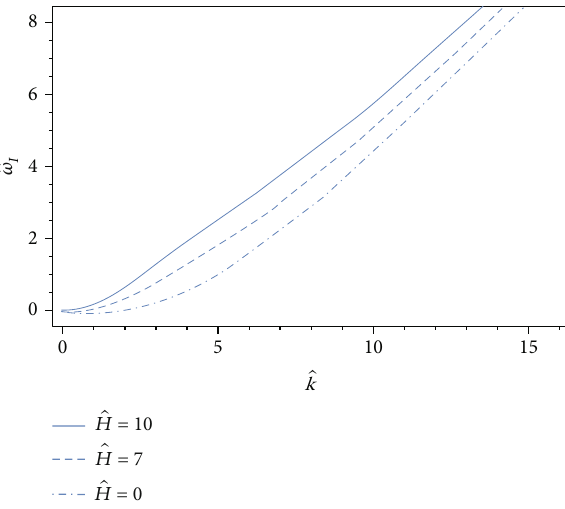
Figure 6: In fl uence of rotation on growth rate curves at b ρ = 0 : 002 , b μ ′ = 0 : 5 , b μ = 0 : 03 , L = 0 : 3 , b β = 0 : 3 , b ε